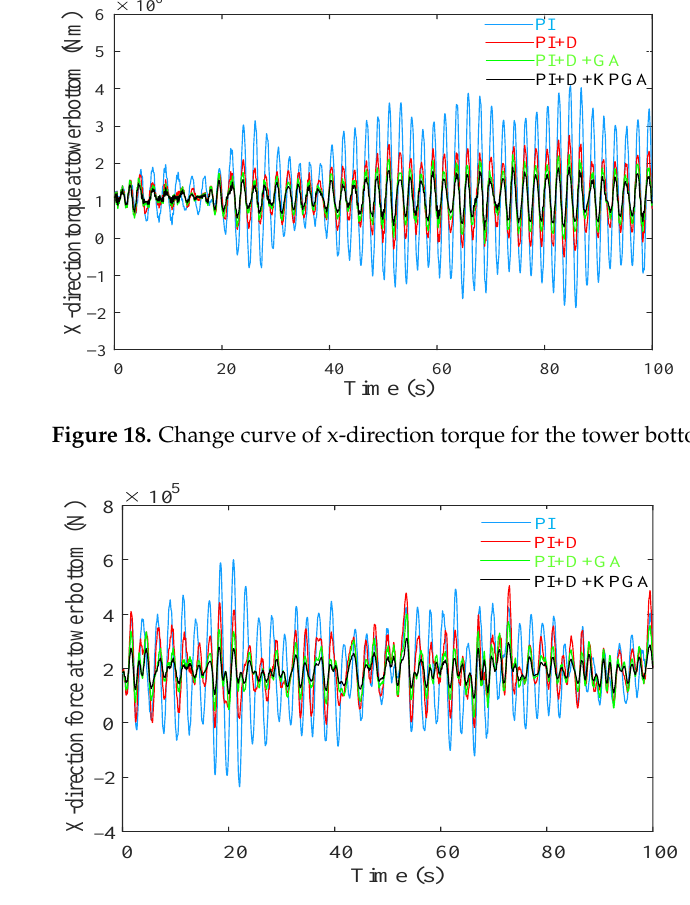
Figure 19. Change curve of x-direction force for the tower bottom.